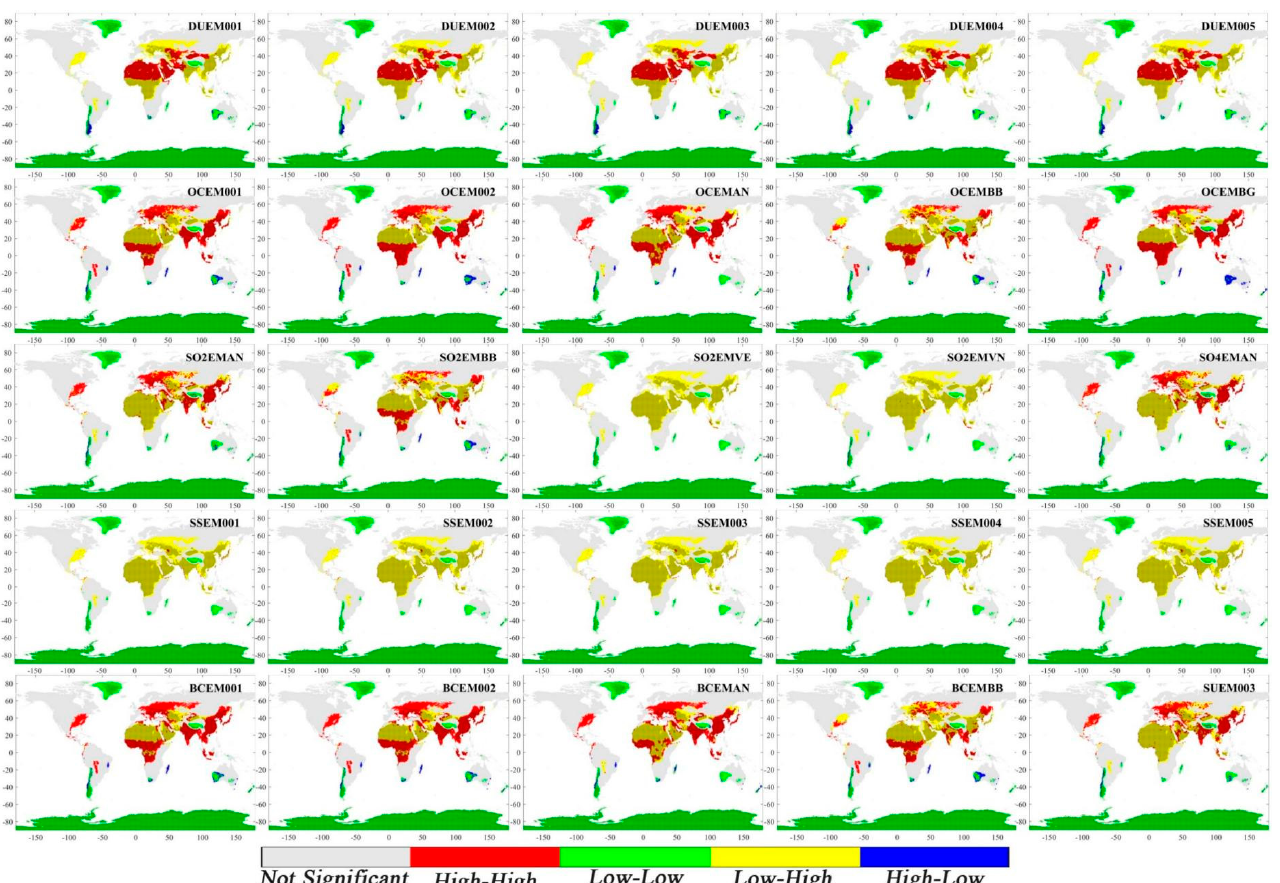
Figure 9. Global spatial aggregation of AOD and aerosol emissions. Sulphur acid-based aerosols are mainly caused by anthropogenic emissions, biomass burning emissions, and volcanic eruption emissions. Thus, SO2EMVE and SO2EMVN do not have high–high aggregation spatial distribution with AOD values. Like OCEMBB and BCEMBB, SO2EMBB is also mainly concentrated in areas with dense vegetation or areas where biomass fuel is the main fuel for daily use. However, unlike OCEMAN and BCEMAN, anthropogenic emissions of sulphur acid-based aerosols are mainly associated with industrial productions, and therefore high SO2EMAN, SO4EMAN, and SUEM003 value areas are mainly located in more densely populated and industrially developed regions such as East Asia, South Asia, Central Europe, and the eastern United States. The areas with high concentrations of marine aerosol emissions and SSAOD of different particle sizes are mainly found in coastal